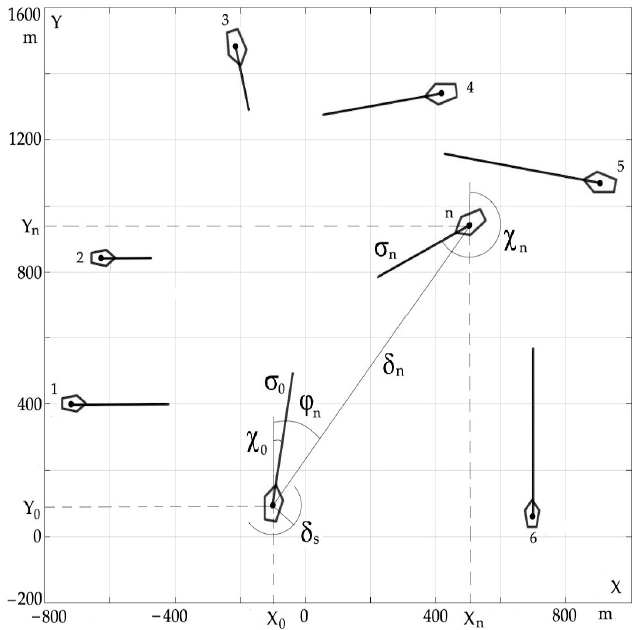
Figure 2. Imaging of the traffic situation of a group of autonomous vehicles: σ 0 , χ 0 —speed and course of our autonomous vehicle; σ n , χ n —speed and course of the n-th other autonomous vehicle, where n = 1,.., N; φ n , δ n —bearing and distance to the n-th other autonomous vehicle; X 0 , Y 0 —position coordinates of our autonomous vehicle; X n , Y n —position coordinates of the n-th other autonomous vehicle.